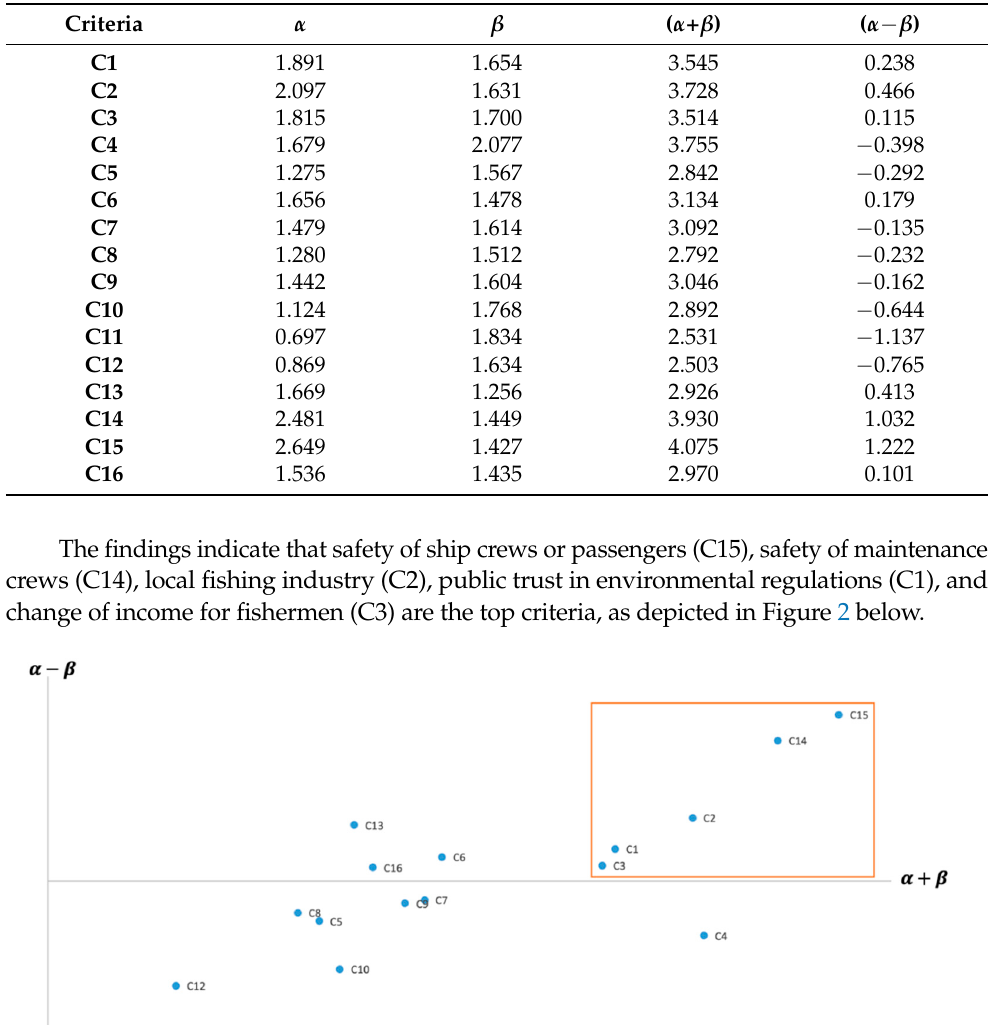
Table 7. Cause–effect model for criteria.